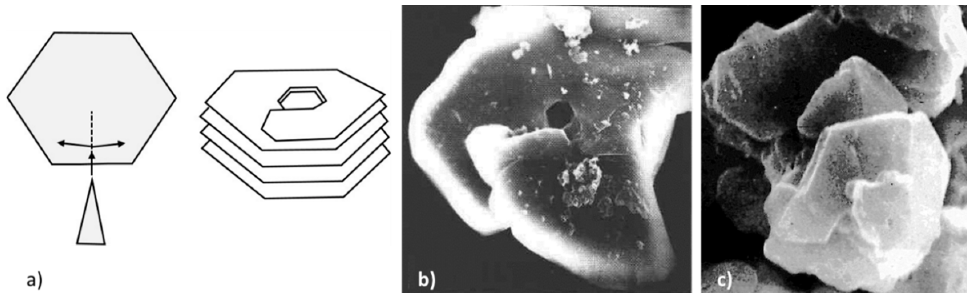
Figure 13. Negative wedge disclination and helical (macro-spiral) growth: ( a ) Schematic representation; ( b ) overlapping segments and hexagonal hole in metamorphic graphite, reproduced from [47] with permission from Canadian Mineralogist; ( c ) chunky graphite in cast iron, reproduced from [48] with permission from the American Foundry Soc.